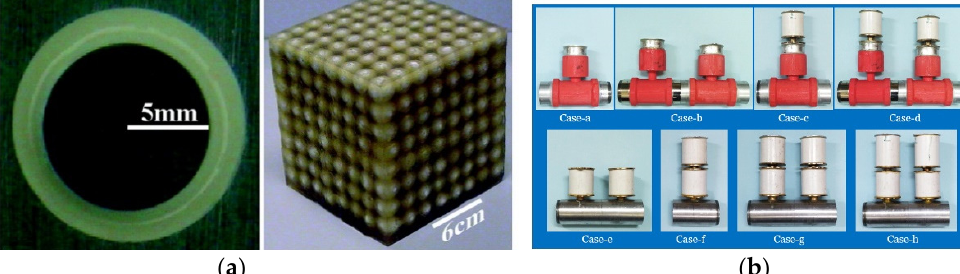
Figure 4. Examples of inertial meta-atom structures: with ( a ) showing a matrix of coated spherical inclusions (From [67]. Reprinted with permission from AAAS). Displayed in ( b ) are various configurations of Helmholtz resonator arrays [68] (Reprinted from Applied Acoustics, Volume 155,